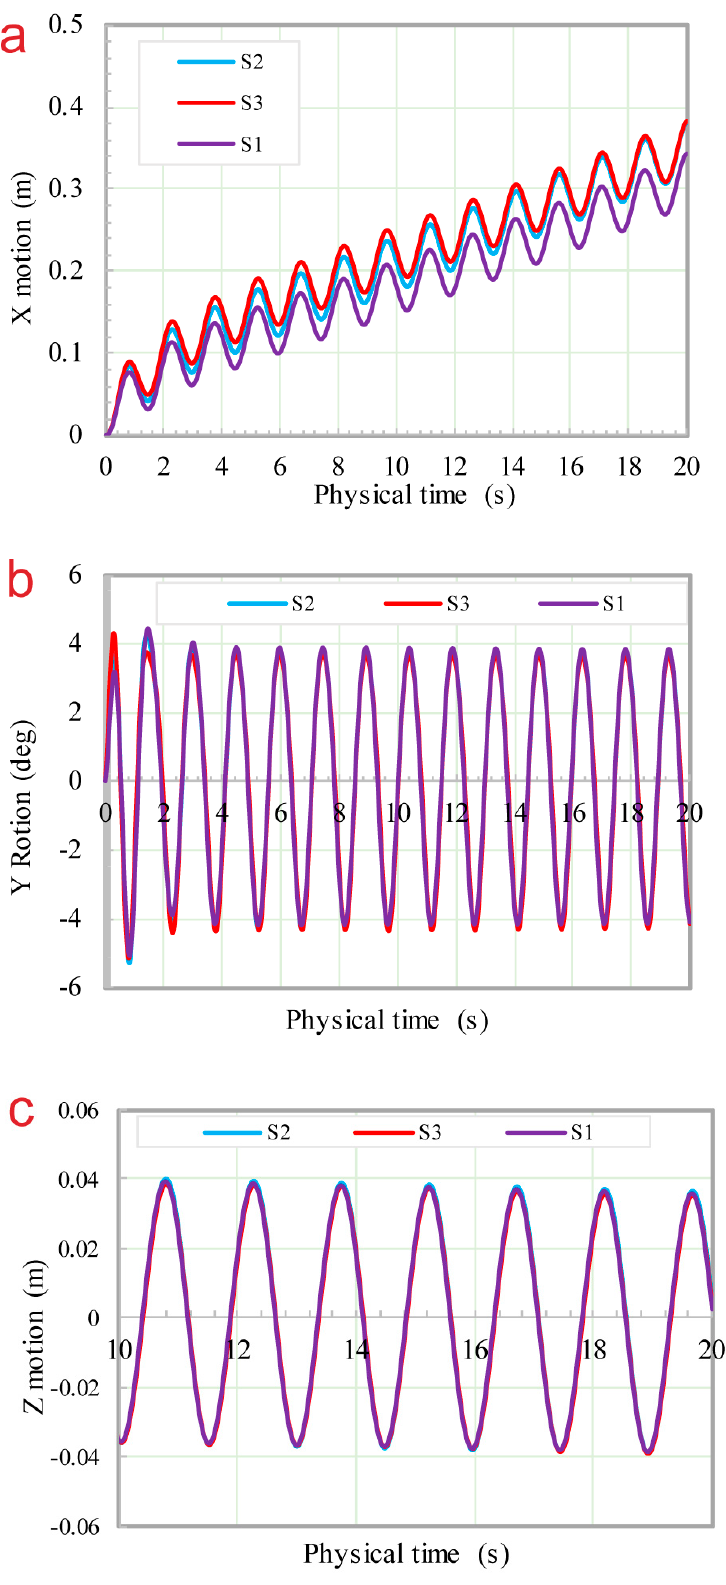
Figure 12. Motions of ice floes along x, y, and z directions in different ice sizes. ( a ) X motion of ice floe; ( b ) Y rotation of ice floe; ( c ) Z motion of ice floe.